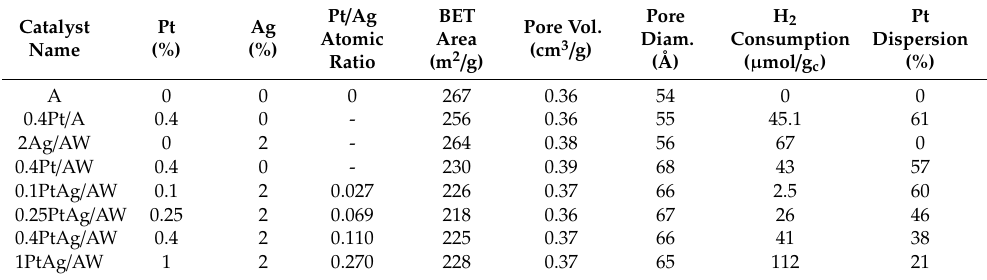
Table 1. Composition of Pt, Ag, and PtAg / Al 2 O 3 catalysts with 2 wt% Ag and 0.5 wt% W